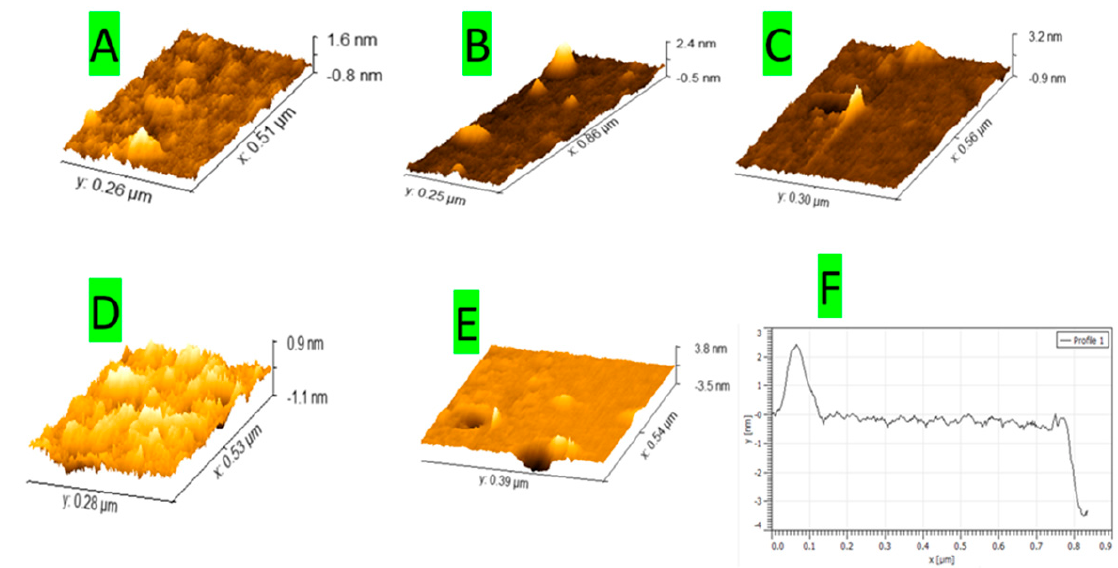
Figure 7. AFM 3D thickness measurements of ZnO structures with different applied voltage EPD system. ZnO surfaces deposited with different voltages: ( A ) 10 V; ( B ) 30 V; ( C ) 60 V; ( D ) APTES functionalized substrate with 10 V; ( E ) APTES functionalized substrate with 60 V; and ( F ) thickness profile of ( E ).